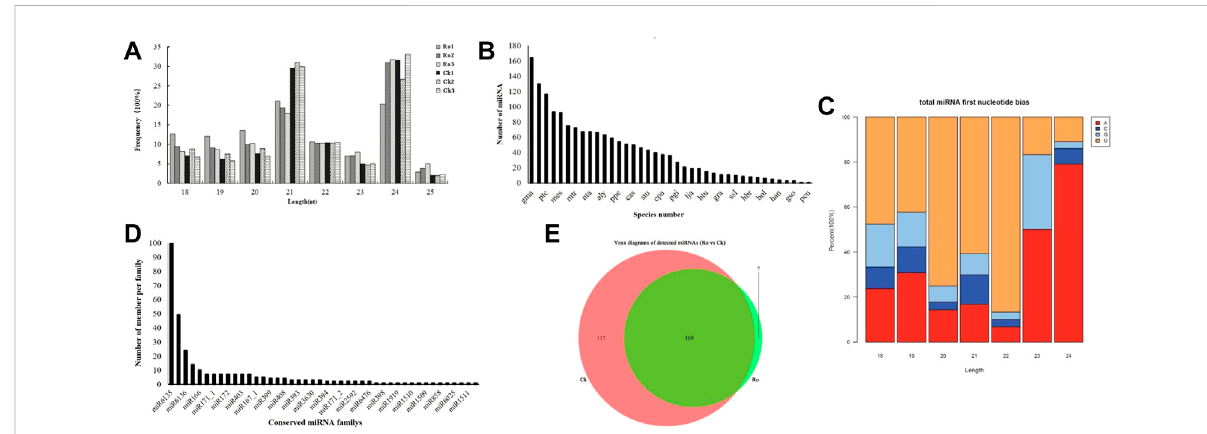
FIGURE 2 Changes in miRNAs in the hairy roots of P. ginseng under ginsenoside Ro stress. Length distribution of the total valid reads (A) . Statistics on the frequency of miRNA of P. ginseng in other species (B) . miRNA fi rst nucleotide bias of P. ginseng (C) . Distribution of the conserved miRNAs of P. ginseng (D) . Venn diagram of the number of common and unique miRNAs in ginseng under ginsenoside Ro stress (E)